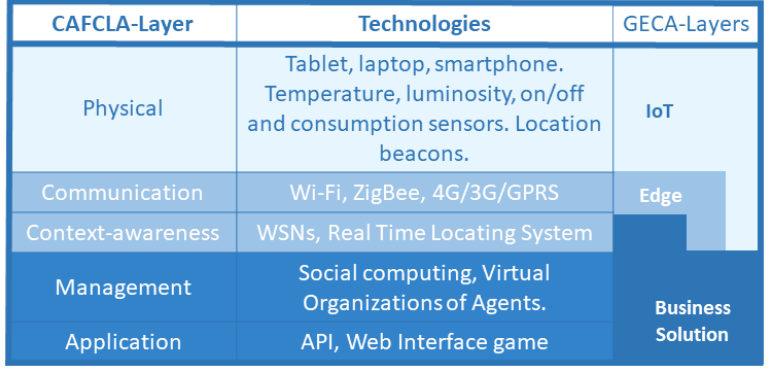
Figure 3. CAFCLA-GECA